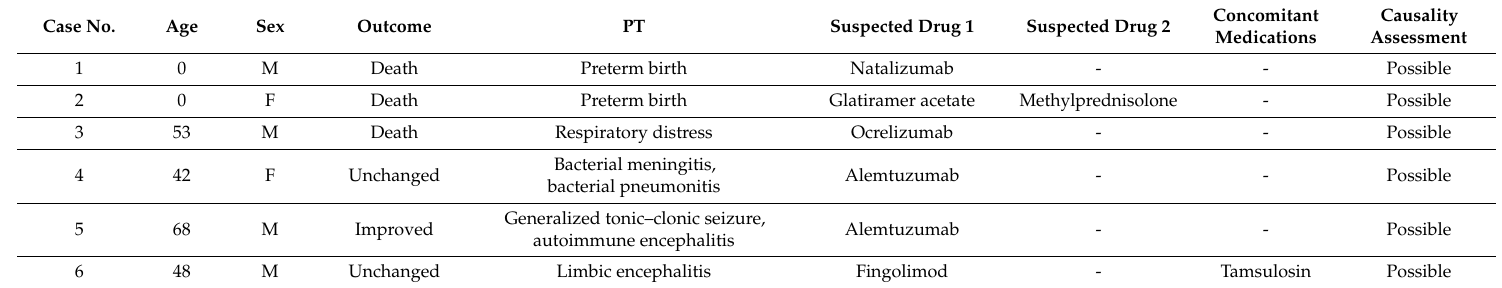
Table 2. Serious Individual Case Safety Reports (ICSRs) that reported ADRs resulting in death or that were life threating. Case